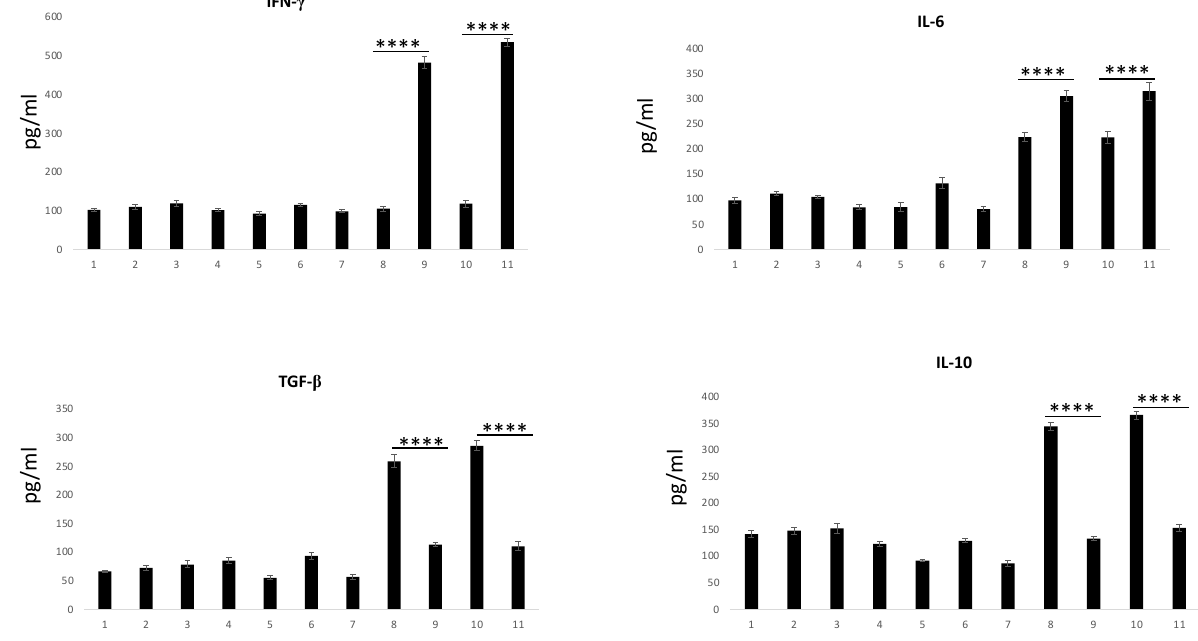
Figure 7: Bcl2 inhibited and Rv3416 stimulated BMDCs induce pro-inflammatory Th1 responses from interacting T cells. BMDCs